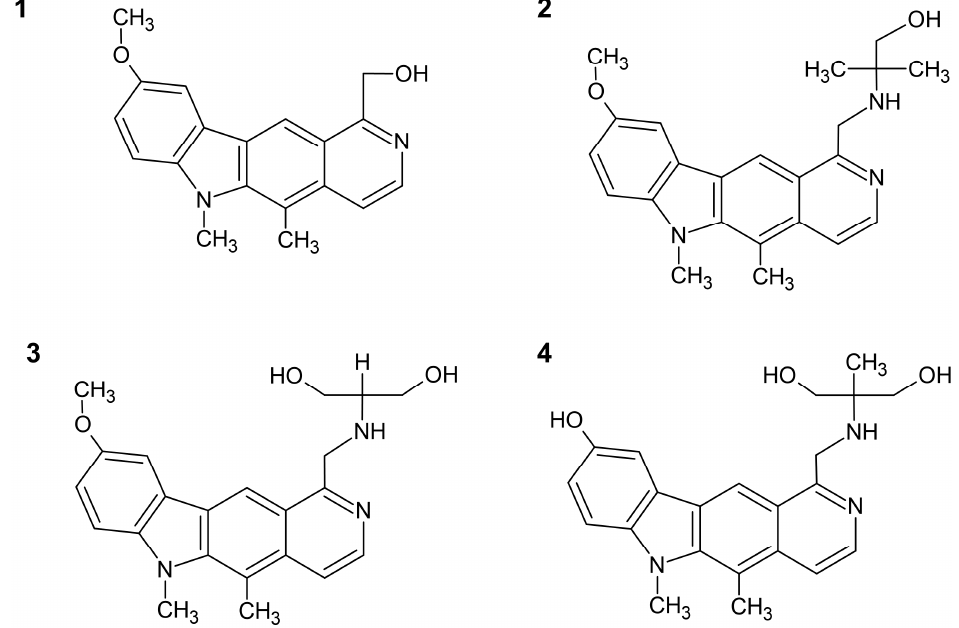
Figure 1. Chemical formulas of tested compounds: ( 1 ) 5,6-dimethyl-9-methoxy-1-hydroxymethyl-6 H -pyrido[4,3- b ]carbazole; ( 2 )5,6-dimethyl-9-methoxy-1-[(1,1-dimethyl-2-hydroxy-ethyl)aminomethyl]-6 H -pyrido[4,3- b ] carbazole; ( 3 ) 5,6-dimethyl-9-methoxy-1-[(1,1-bis-hydroxymethyl-methyl)aminomethyl)]- 6 H -pyrido[4,3- b ] carbazole; ( 4 ) 5,6-dimethyl-9-hydroxy-1-[(1,1-bis-hydroxymethyl-ethyl)aminomethyl]- 6 H -pyrido[4,3- b ]